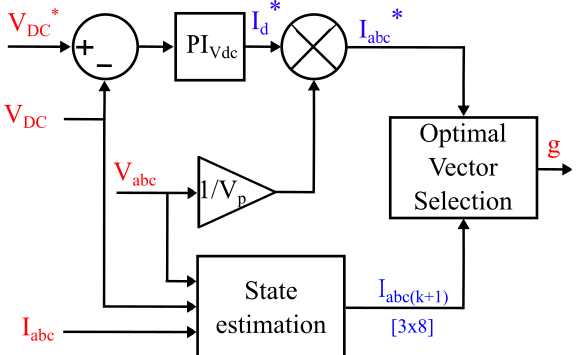
Figure 27. OSV-MPC without PLL in a natural reference frame.